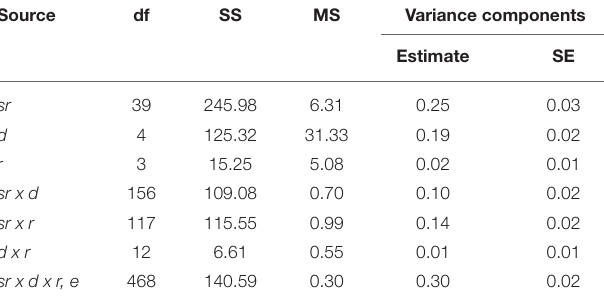
TABLE 3 | Variance decomposition for score report ratings.